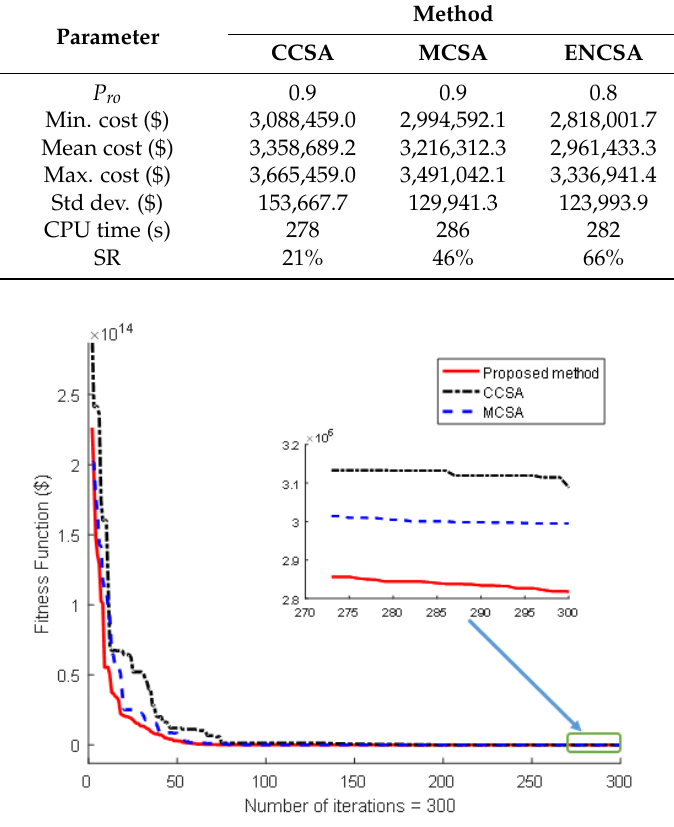
Figure 4. Fitness function convergence characteristics for the IEEE 118 buses system.